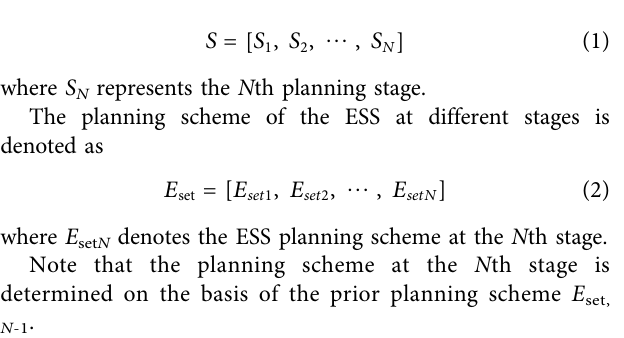
Frontiers in Energy Research |